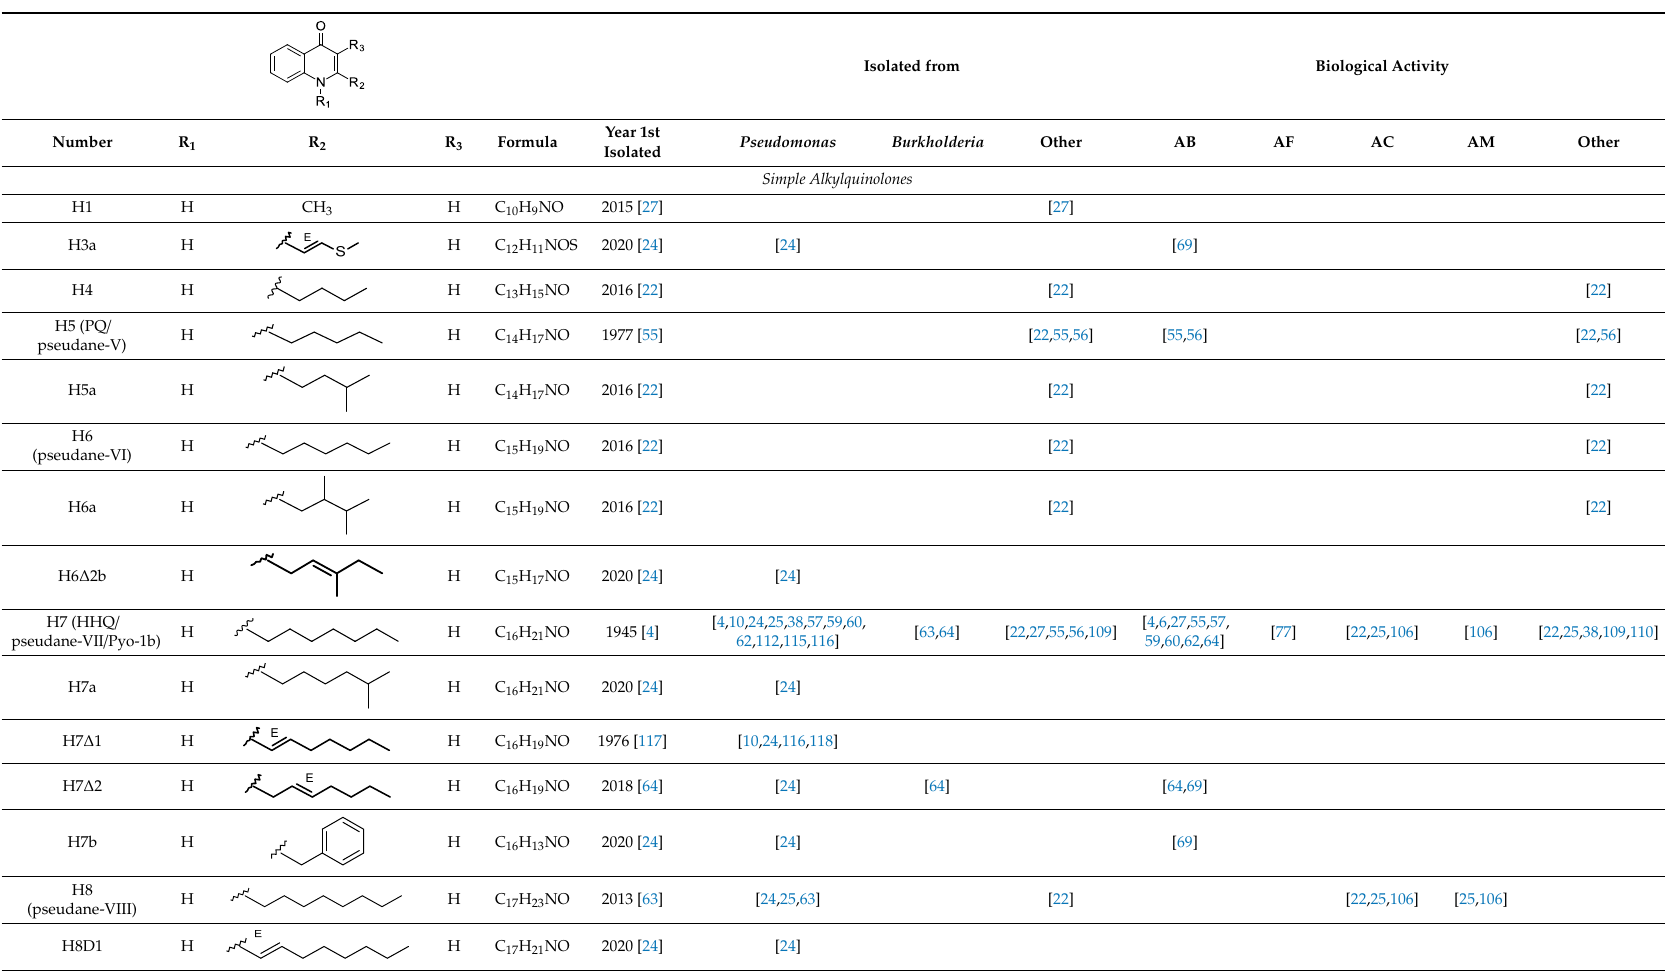
Table A1. Alkyl-4-quinolones isolated from bacteria.